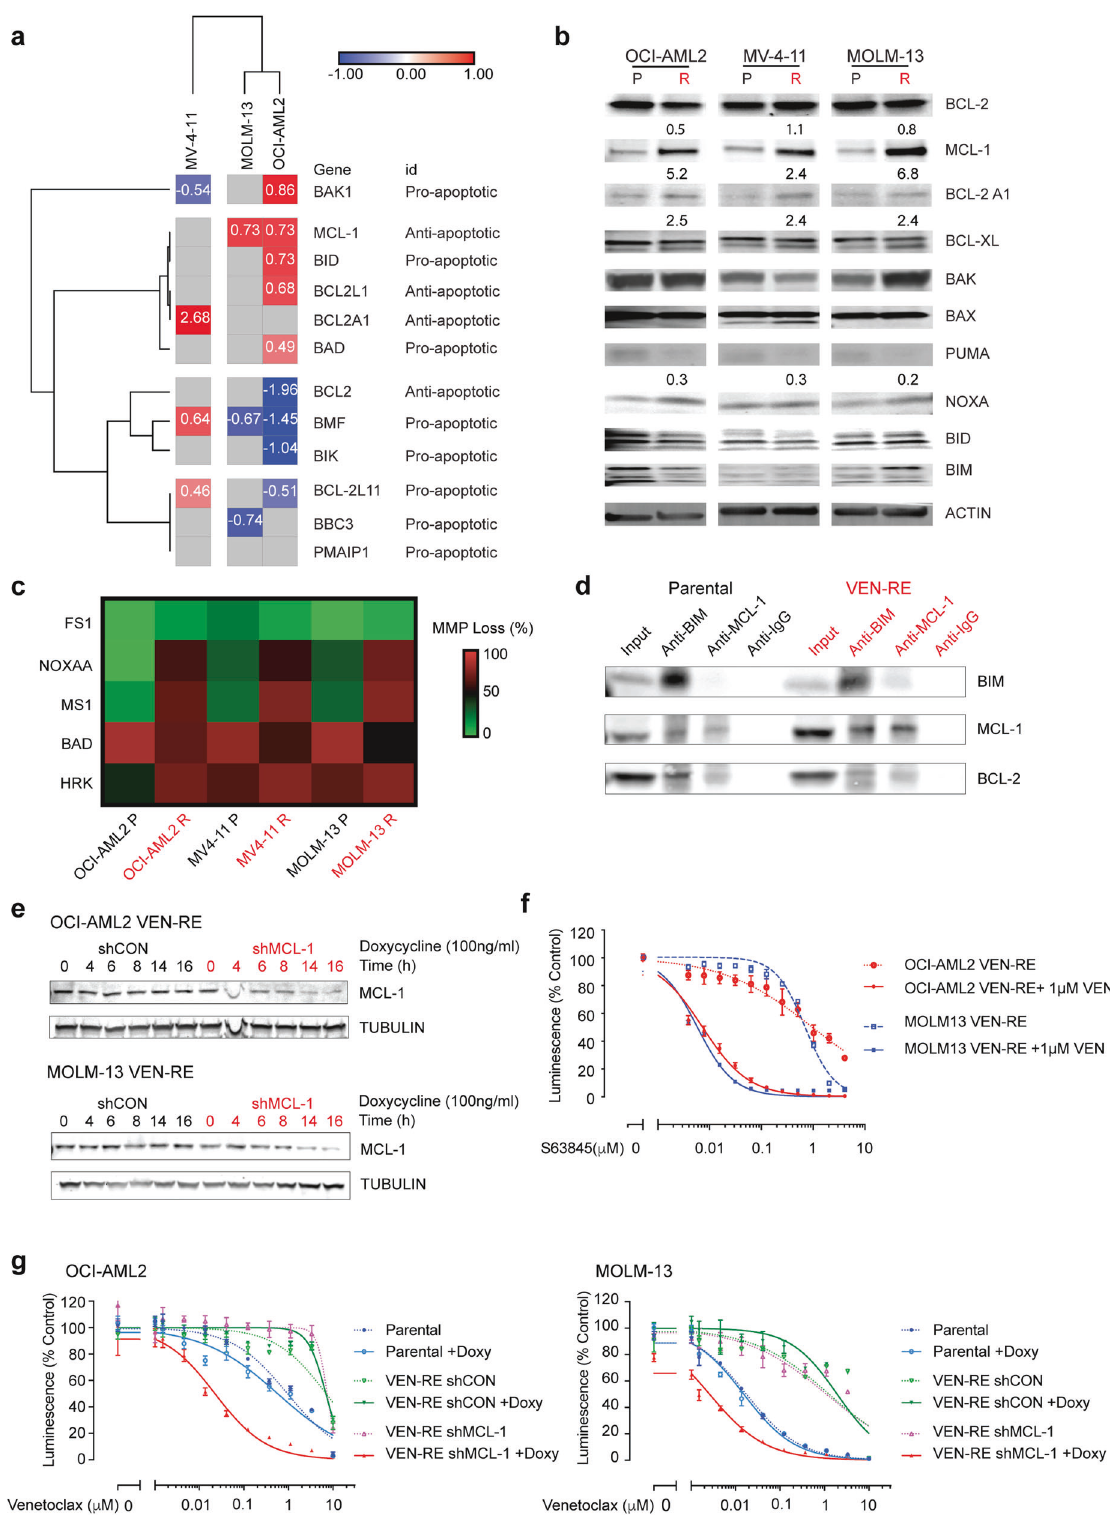
To validate this, we next examined mitochondrial respiration using Seahorse XF. While parental cells exhibited a dose- dependent increase in the maximum oxygen consumption rate (OCR) with mitochondrial uncoupling by carbonyl cyanide-4- (tri fl uoromethoxy) phenylhydrazone (FCCP), the VEN-RE cells had Signal Transduction and Targeted Therapy (2022)